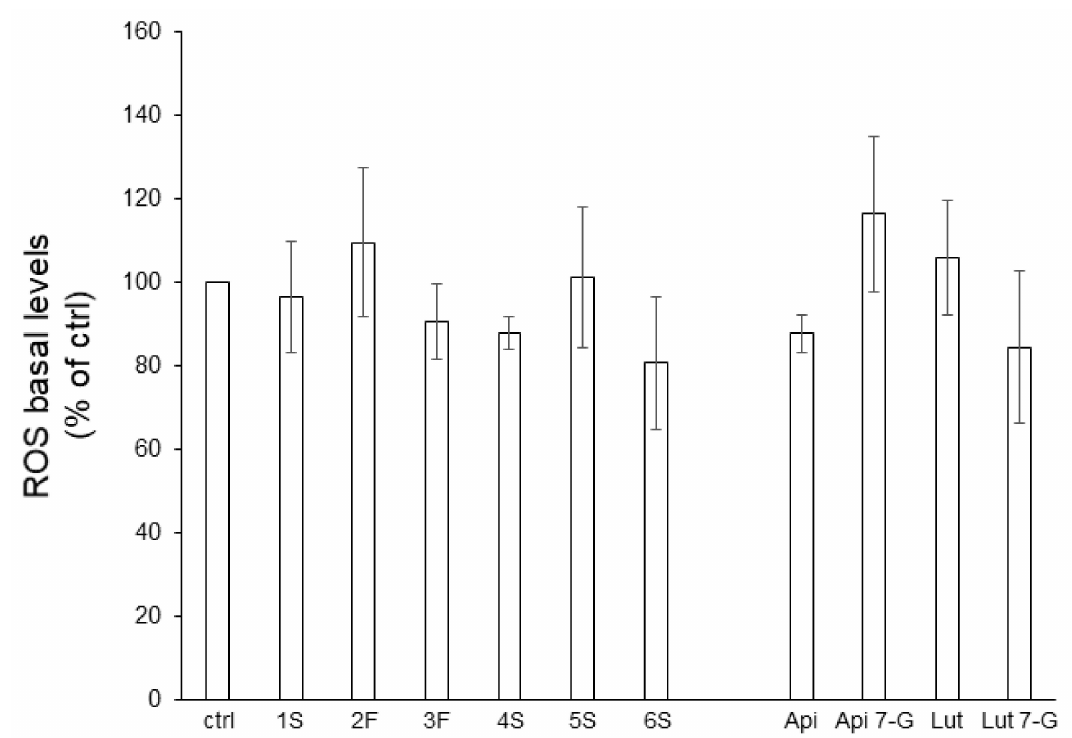
Figure 6. Effect of chamomile extracts and pure flavones on ROS basal levels. Caco2 cells were grown for 24 h in the absence (ctrl) or in the presence of 100 µ g/mL of each extract or 0.5 µ g/mL apigenin (Api), 5 µ g/mL apigenin-7-O-glucoside (Api 7-G), 1.5 µ g/mL luteolin (Lut), or 3 µ g/mL luteolin-7-O-glucoside (Lut 7-G), and then incubated with 10 µ M DCFH-DA for 30 min. Afterwards, ROS levels were quantified by FACS analysis. Data are reported as percentage of untreated cells (ctrl) arbitrarily set to 100%. Results represent the means ± SEM of 3 independent experiments, each performed in